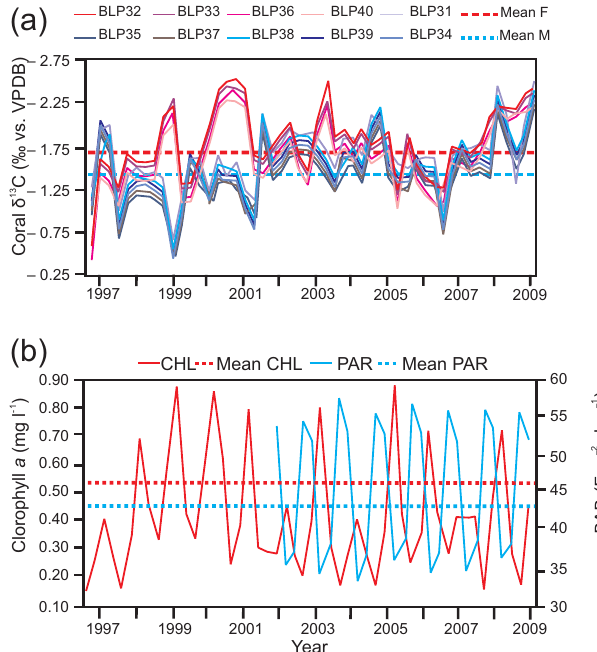
Figure 4. (a) Seasonal variation in δ 13 C composition (VPDB) from Porites panamensis coral colonies along the major growth axis. Blue lines represent male colonies; red lines represent female colonies; red dotted line female colonies’ regime mean; blue dotted line, male colonies’ regime mean. (b) Satellite chlorophyll a and PAR (1997–2009) records. Clorophyll a (red line; mgL − 1 ) , mean chlorophyll a (dotted red line; mgL − 1 ) , photosynthetically active radiation (blue line; E m − 2 d − 1 ) , photosynthetically active radia- tion (dotted blue line; E m − 2 d − 1 )